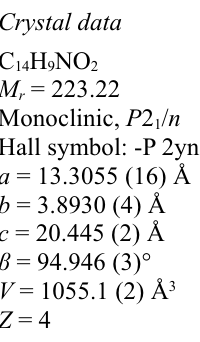
The crystal packing viewed down the b axis. C-H···O hydrogen bonds are shown as dashed lines. 2-Phenyl-4 H